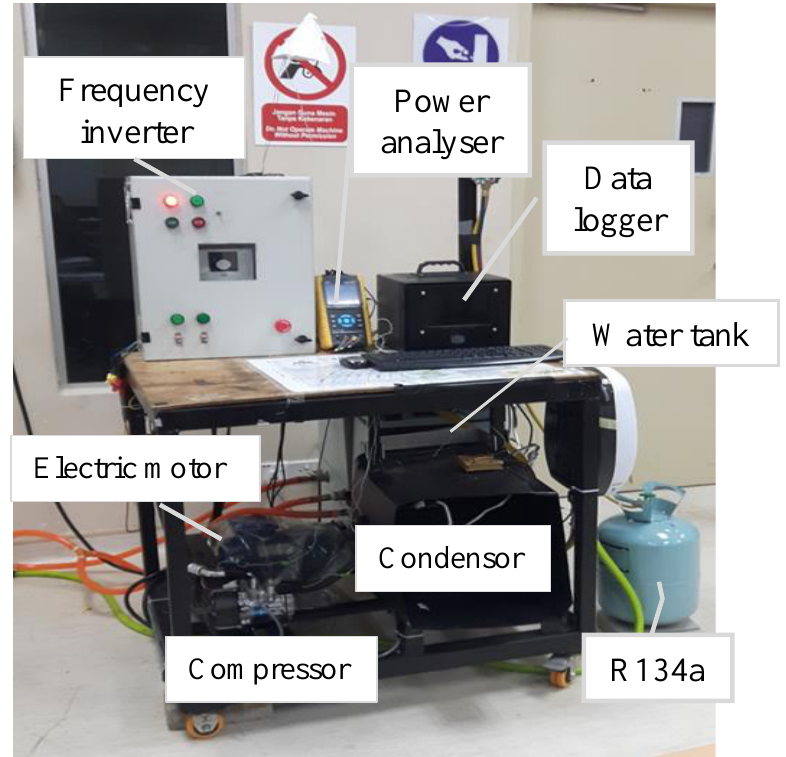
Figure 4. AAC system experimental test bench.